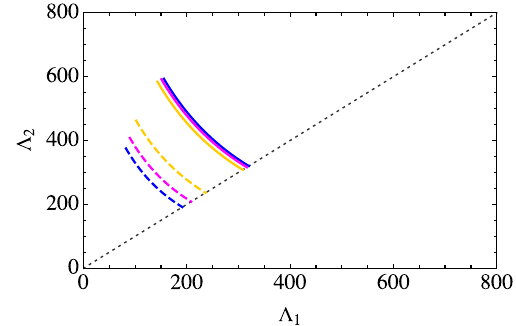
Fig. 7 ((cid:2) 1 ,(cid:2) 2 ) relation obtained for the case of GW190425. The black-dotted line stands for (cid:2) 1 = (cid:2) 2